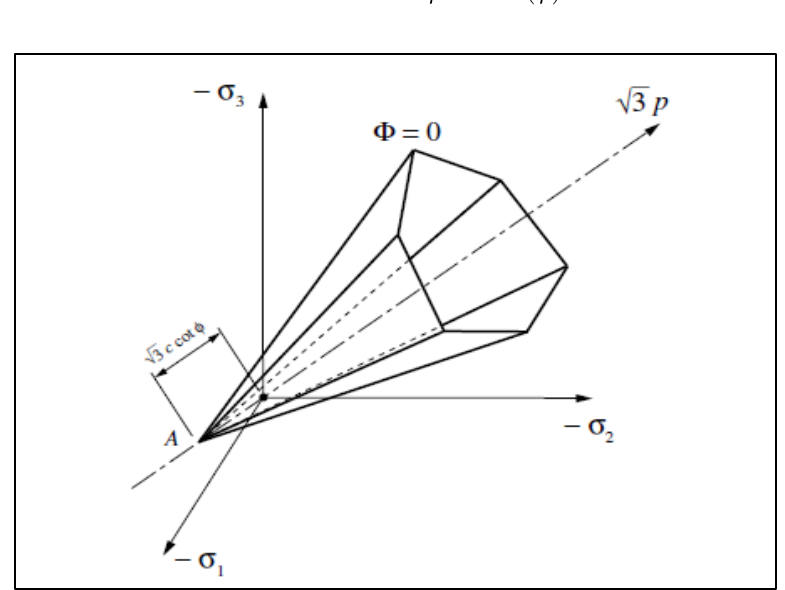
Figure 1. Mohr–Coulomb yield surface in principal stress space [1].